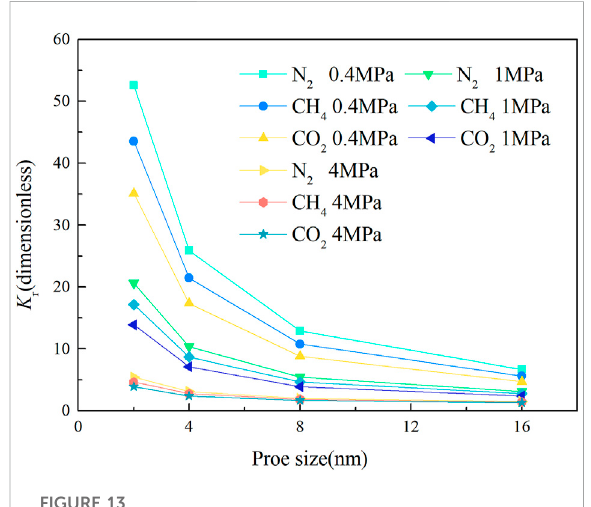
FIGURE 13 Variation in the dimensionless permeability coef fi cient with proe size P avg for different